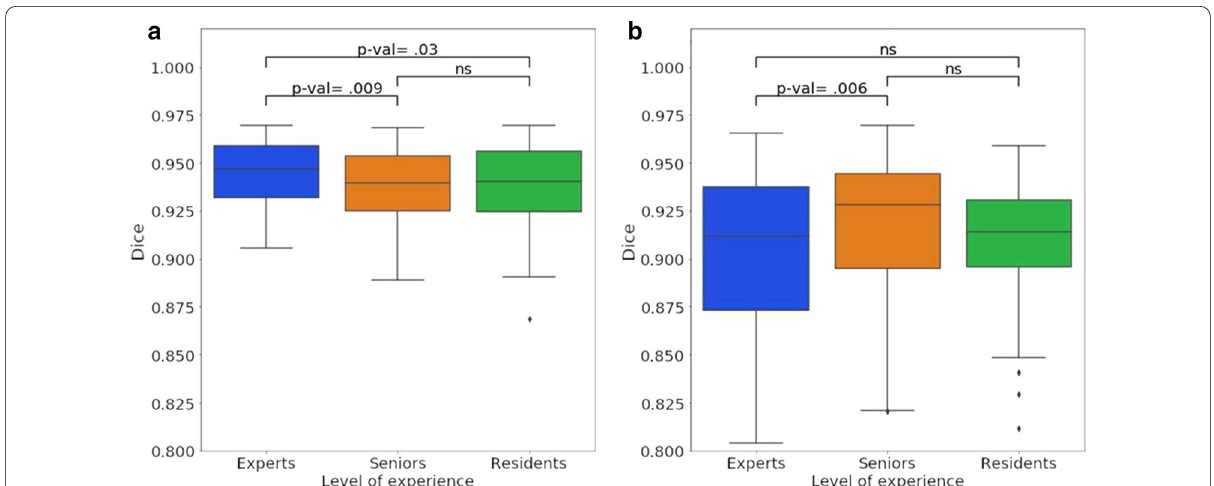
Fig. 6 Impact of the readers’ level of expertise (expert/senior/resident) on segmentation variability evaluated by DSC, for WG ( a ) and TZ ( b ) segmentation (ns not =